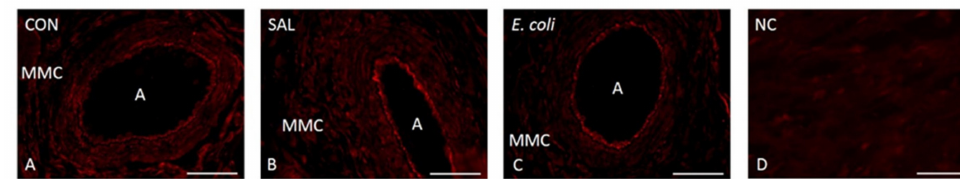
Figure 3. Representative pictures show pituitary adenylate cyclase-activating peptide receptor (PAC1R) immunostaining in the myometrial layer of gilts from the control (CON), saline (SAL) and E. coli ( E. coli ) groups. Positive immunoreaction to PAC1R is visible in muscle cells and arteries (endothelium, muscle layer) of the myometrium of the control ( A ), saline-injected ( B ) and inflamed ( C ) uteri. Negative control (NC) for PAC1R ( D ) was obtained by omitting the primary antibody. MMC—myometrial muscle cells; A—artery. The scale bar of each image is 50 µ m in length.